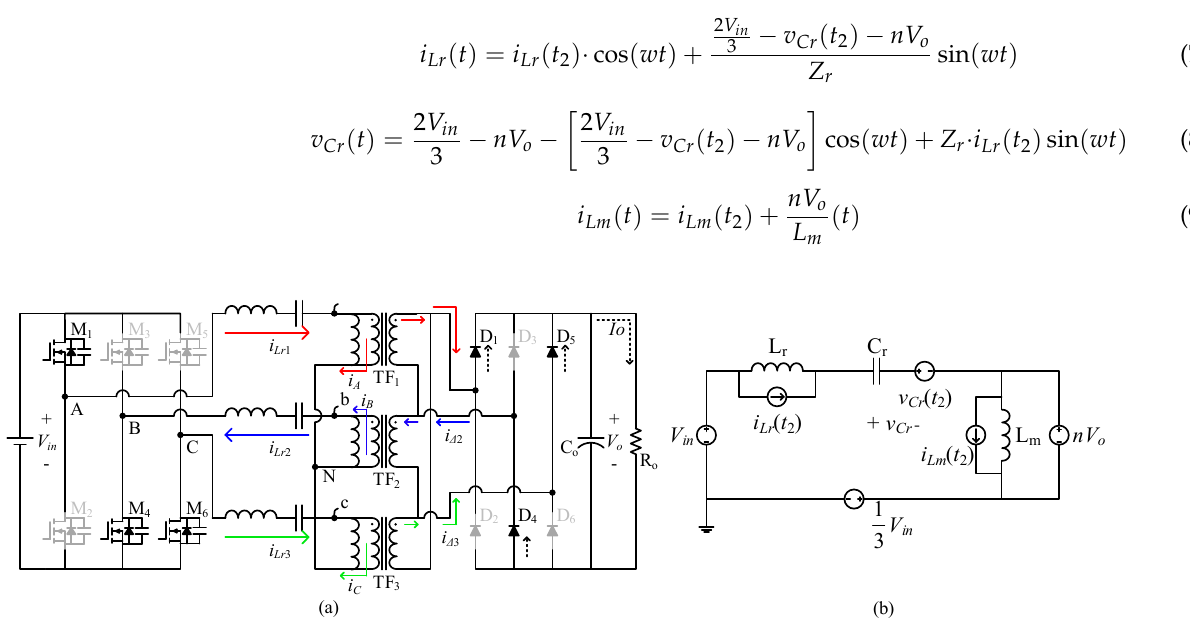
Figure 6. ( a ) Circuit station at Stage 3 ( b ) Equivalent circuit at Stage 3.